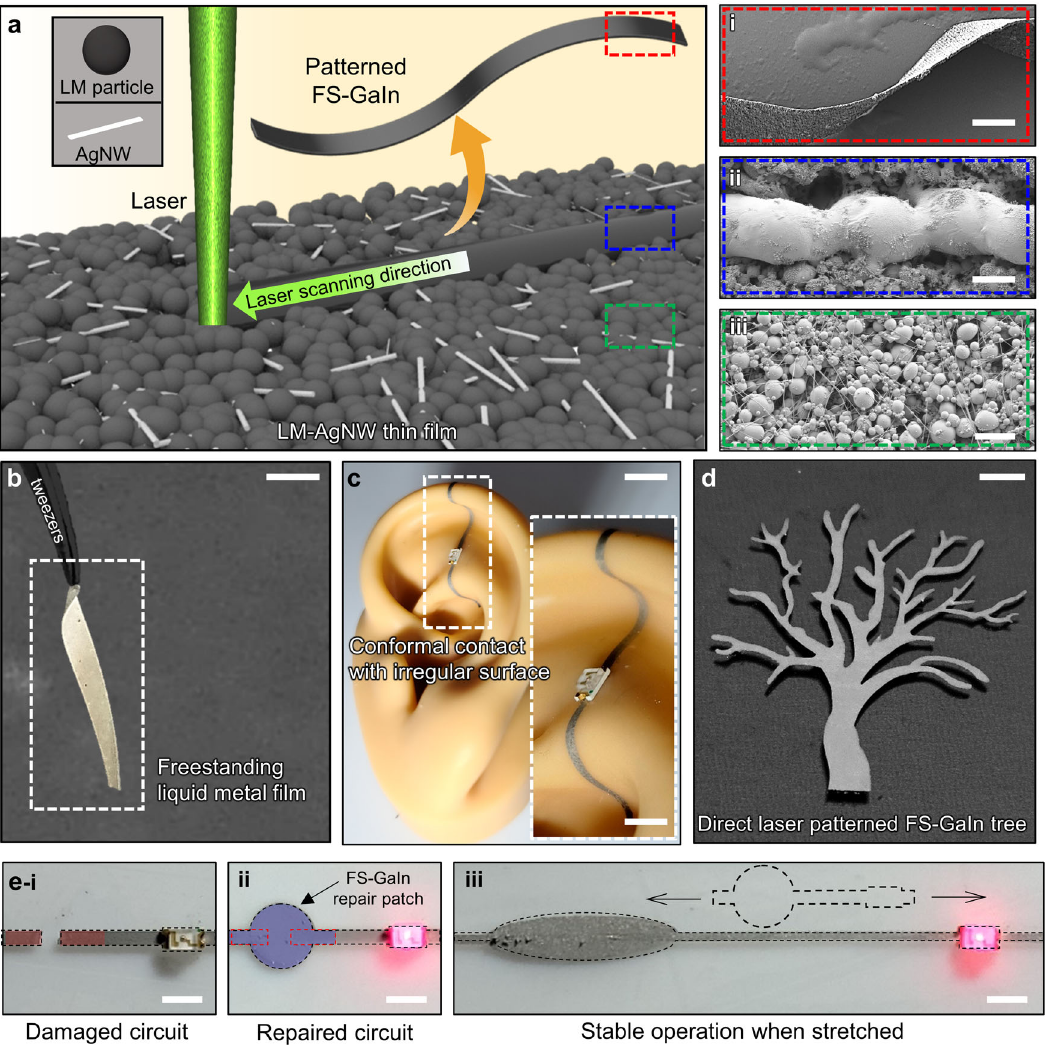
Fig. 1 Freestanding LM-AgNW thin- fi lm conductor (FS-GaIn). a Schematic illustration of the FS-GaIn fabrication process (i) SEM of the FS- GaIn. (ii, iii) SEM of the LM-AgNW thin- fi lm after and before laser exposure, respectively. b The FS-GaIn held by tweezers. c Conformal contact of the FS-GaIn with a human ear model and a rigid component. d The tree-patterned FS-GaIn. e In situ circuit reconnection with a FS-GaIn repair patch and stretchability after reconnection. (i) A disconnected circuit with LED off. (ii) The reconnected circuit by the FS-GaIn repair patch with LED on. (iii) Stable operation of the repaired circuit under stretched condition with the well-operating LED and the repair patch. Scale bars: 200 μ m ( a -i), 6 μ m ( a -ii, iii), 2 mm ( b ), 10 mm ( c ), 4 mm ( c inset), 3 mm ( d , e